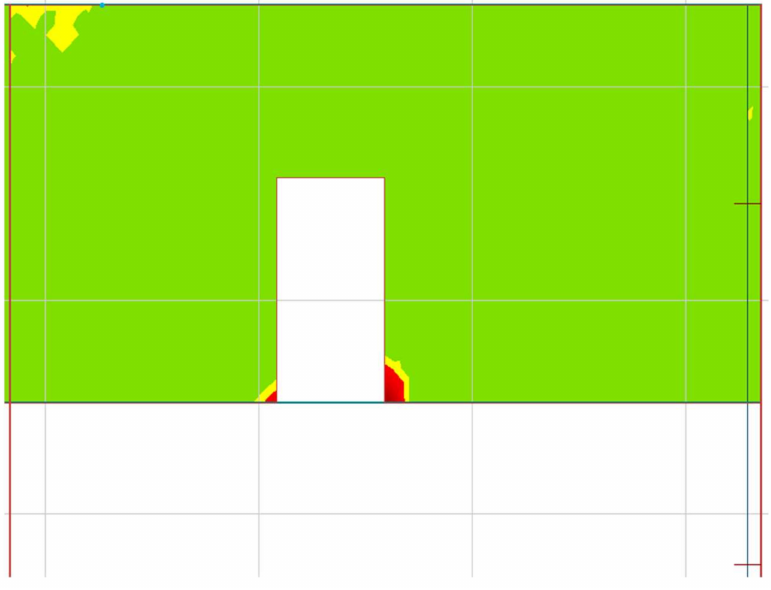
Figure 18. Utilization ratio of EW in contour after cutout